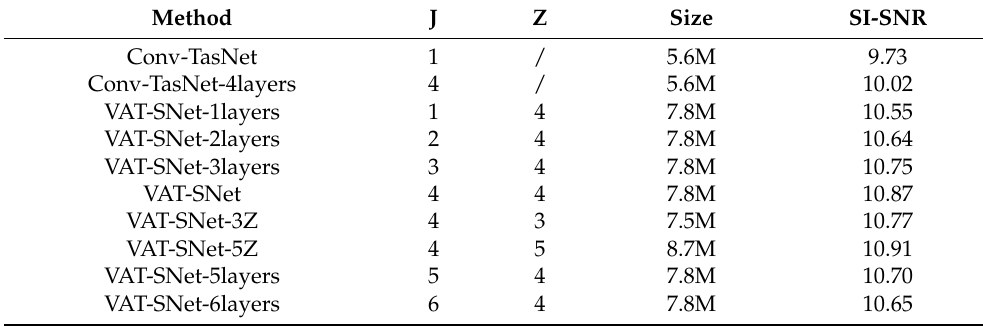
Table 2. Training model parameter settings.